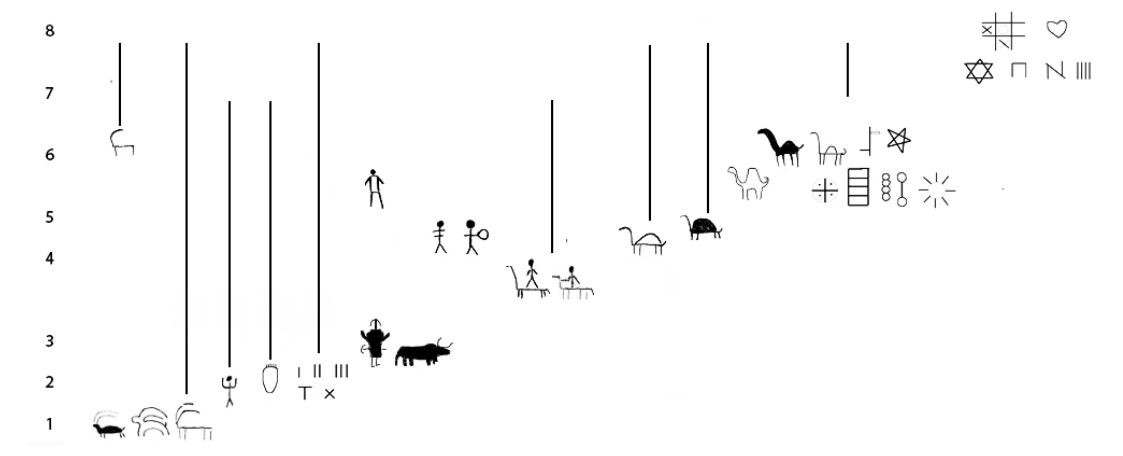
Figure 4 Schematic chronology of Negev rock art. 1. Middle (?) Timnian, 2. Late Timnian, 3. Inter- mediate Bronze Age, 4. Post introduction of the horse into the Negev, ca. 4000 BP, 5. Post introduction of the camel into the Negev, ca. 3000 BP, 6 Roman era, 7. Early Islamic